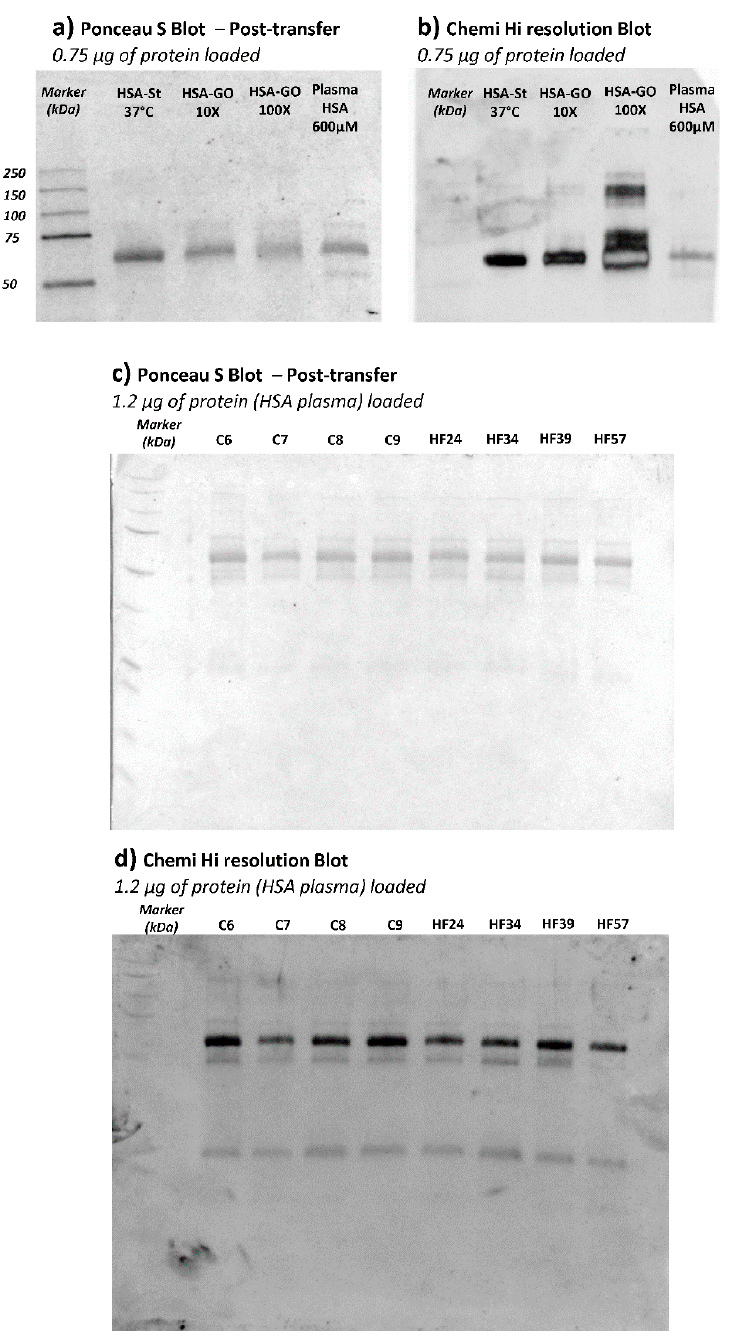
Figure 6. Ponceau S-stained blotted membrane of HSA AGE/ALE standards (HSA incubated at 37 °C, HSA incubated with glyoxal at 1:10 and 1:100 molar ratio), panel a; Anti-CML chemi-blot membrane (HSA AGE/ALE standards) acquired after 3 sec of exposure in high-resolution mode, panel b; Ponceau S-stained blotted membrane of four CTRL plasma samples (C 6-7-8-9) together with four HF plasma samples (HF 24-34-39-57), panel c; Anti-CML chemi-blot membrane (CTRL/HF plasma samples) acquired after 3 sec of exposure in high-resolution mode, panel d. N ε -(Carboxymethyl)lysine (CML) protein adducts in plasma (CTRL and HF sam- ples) were measured using a commercial competitive ELISA Kit; the kit is designed to outline the CML protein content expressed as a concentration value (ng CML-prot/mL); 10 HF plasma samples and 7 CTRL samples were measured in triplicate.